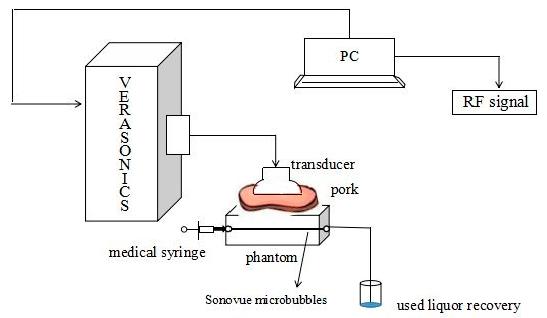
Figure 1. The phantom experiment setup (with pork).